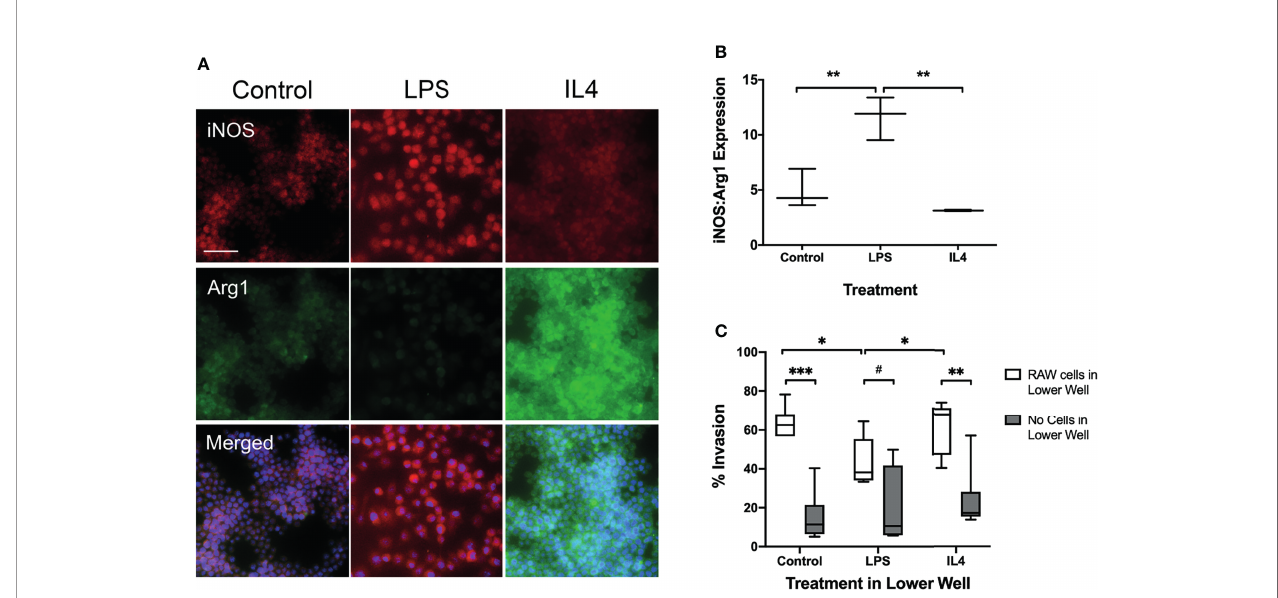
FIGURE 1 | Transwell migration assay with RAW 267.4 macrophages and EO771 metastatic tumour cells. (A) Immuno fl uorescent staining of pro-in fl ammatory marker iNOS and anti-in fl ammatory marker Arg1 in macrophages to assess phenotype following incubation with either the pro-in fl ammatory stimulus LPS or the anti- in fl ammatory cytokine IL4. Bottom panel of images also contains nuclear (DAPI) counterstain (blue). (B) Graph showing ratio of iNOS : Arg1 expression in macrophages treated with either LPS (n = 6) or IL4 (n = 6), compared to untreated macrophages (n = 6). (C) Graph showing percentage of EO771 tumour cells migrating through the Matrigel coated Transwell membrane in the presence of either LPS (n = 6) or IL4 (n = 6) stimulated or untreated (n = 6) macrophages (white bars), or the stimulus media alone without macrophages (grey bars). Data shown as box and whisker plots depicting full range of data points. Scale bar = 100 µm. *p < 0.05, **p < 0.01, ***p < 0.001, # p = 0.0756 ”